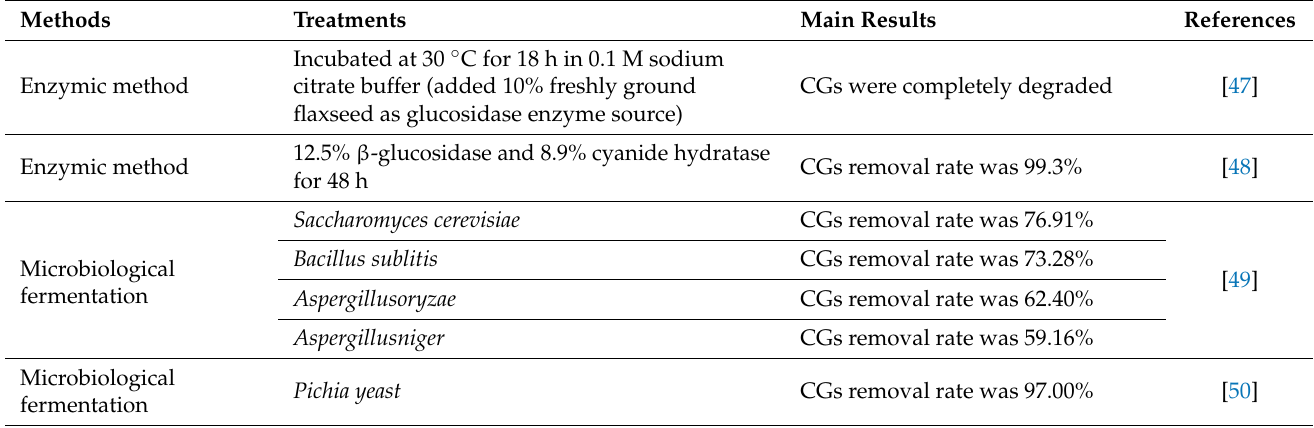
Table 3. Effect of biological method on cyanogenic glycoside in flaxseed